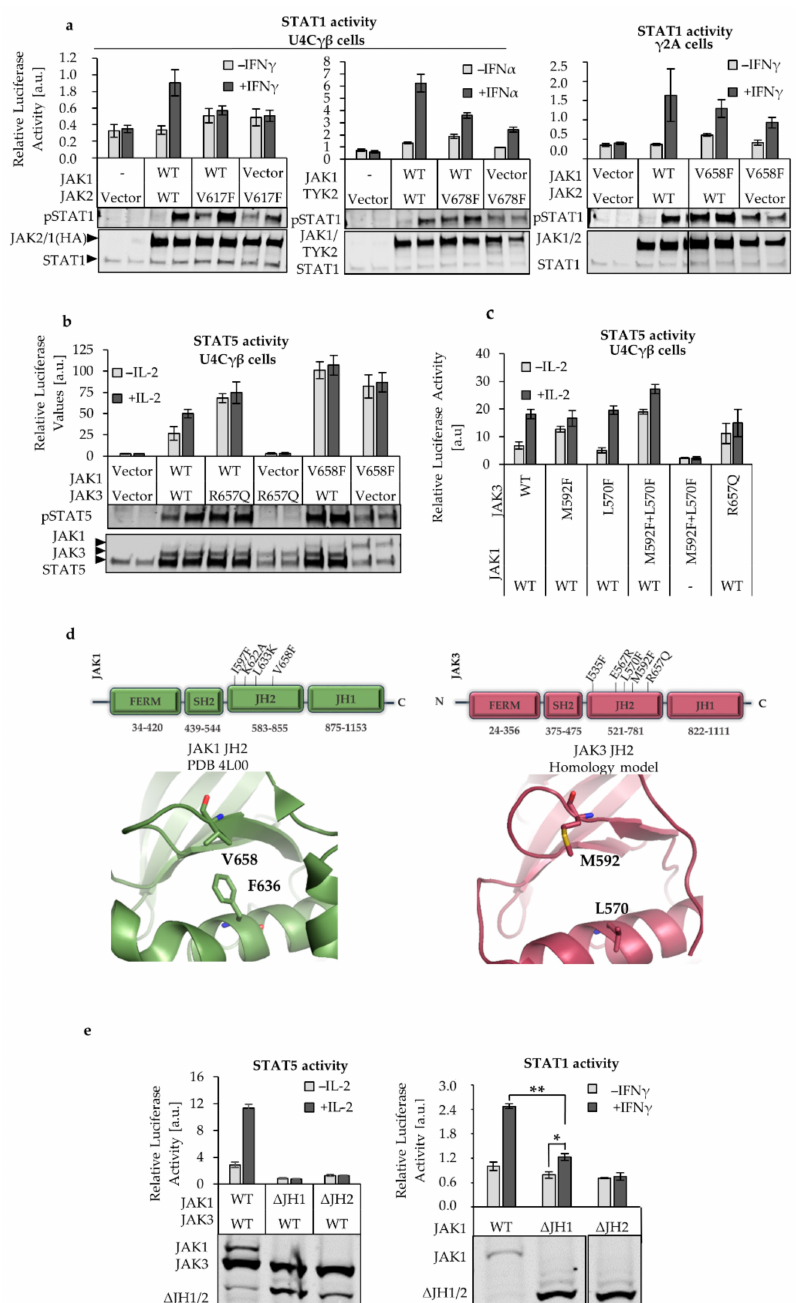
Figure 1. Comparison of JAK JH2s. ( a ) Janus kinases (JAK1, JAK2 and TYK2) hyperactive mutants can activate STAT1 without the partner JAK. pSTAT1 analysis and the transcriptional activity of STAT1 were detected from U4C γβ and γ 2A cells that were transfected for 24 h with JAK2 V617F, TYK2 V678F or JAK1 V658F. Wild-type (WT) partner JAK or vector was co-transfected with the activating mutants. Cells were starved overnight, and left untreated or stimulated with 100 ng / mL interferon γ (IFN γ ) and interferon α (IFN α ) for 20 min after which the pSTAT1 was detected by immunolabeling. For the STAT1 transcriptional activity detection, IRF-GAS or ISRE-luc plasmids) were co-transfected for 43 h with renilla plasmid (pRL-TK) (see Materials and Methods). Cells were stimulated or starved for 5 h, and the luciferase activity was measured. The values were divided with the renilla values to reduce the e ff ects the possible di ff erences in the transfection e ffi ciency might have. Errors are SD of triplicates. Below are representative immunoblots of whole-cell lysates from U4C γβ and γ 2A cells transiently transfected with full-length hemagglutinin (HA)-tagged JAK mutants with or without JAK WT, as indicated. The cell lysates were immunolabeled with pSTAT1 (STAT1 Y701 phosphorylation), HA